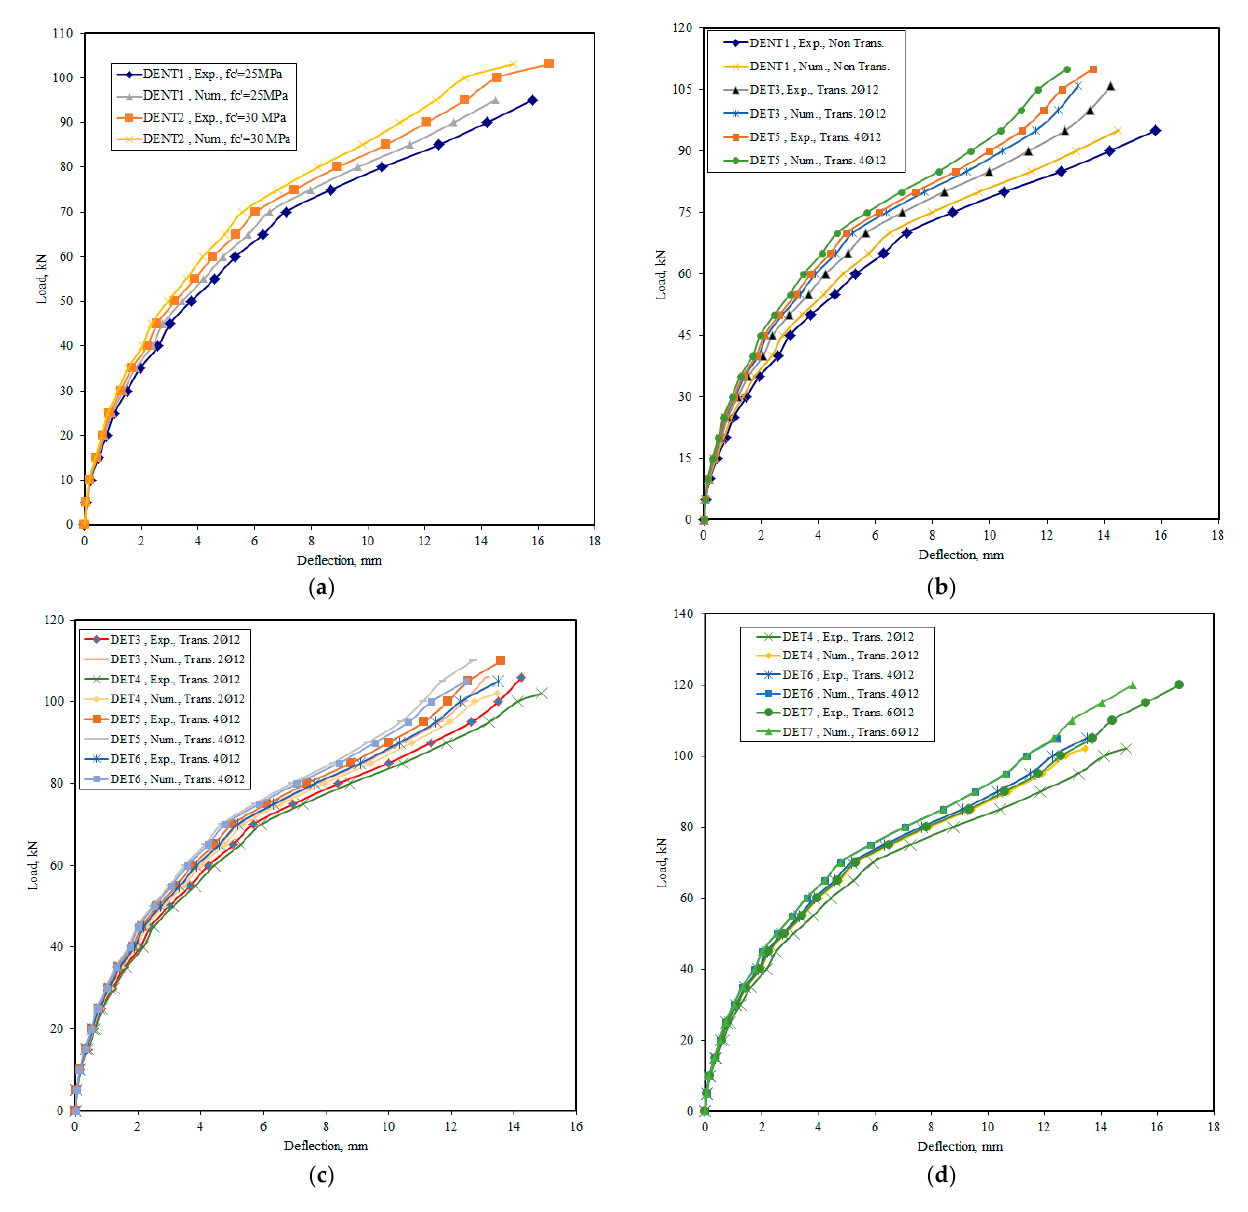
Figure 17. Load-deflection curves for the RC girders with dapped ends and different influencing parameters. ( a ) Load versus deflection curves for different concrete compressive strengths. ( b ) Load versus deflection curves for solid and open sections with different strengthening ratios. ( c ) Load versus deflection curves for solid and open sections with different bolt numbers (normal strand). ( d ) Load versus de fl ection curves for open sections with di ff erent bolt numbers (normal strand).